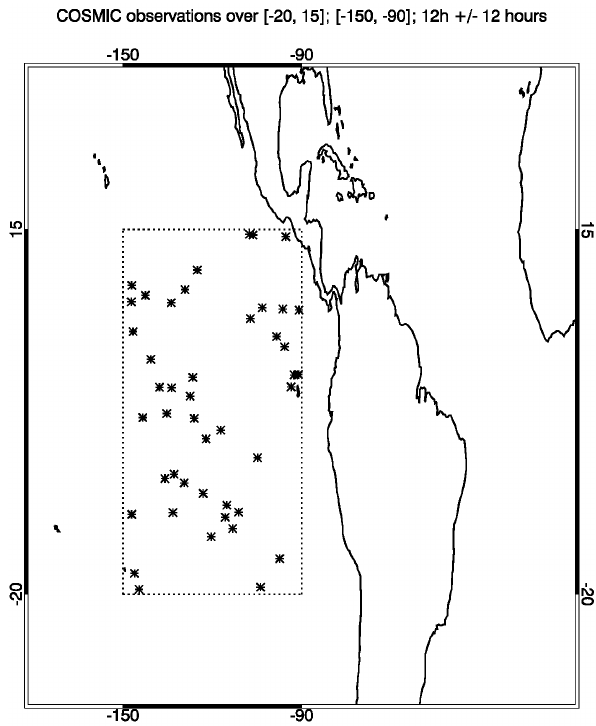
Fig. 5. COSMIC observations coincident with the area of the cirrus cloud on 28 January